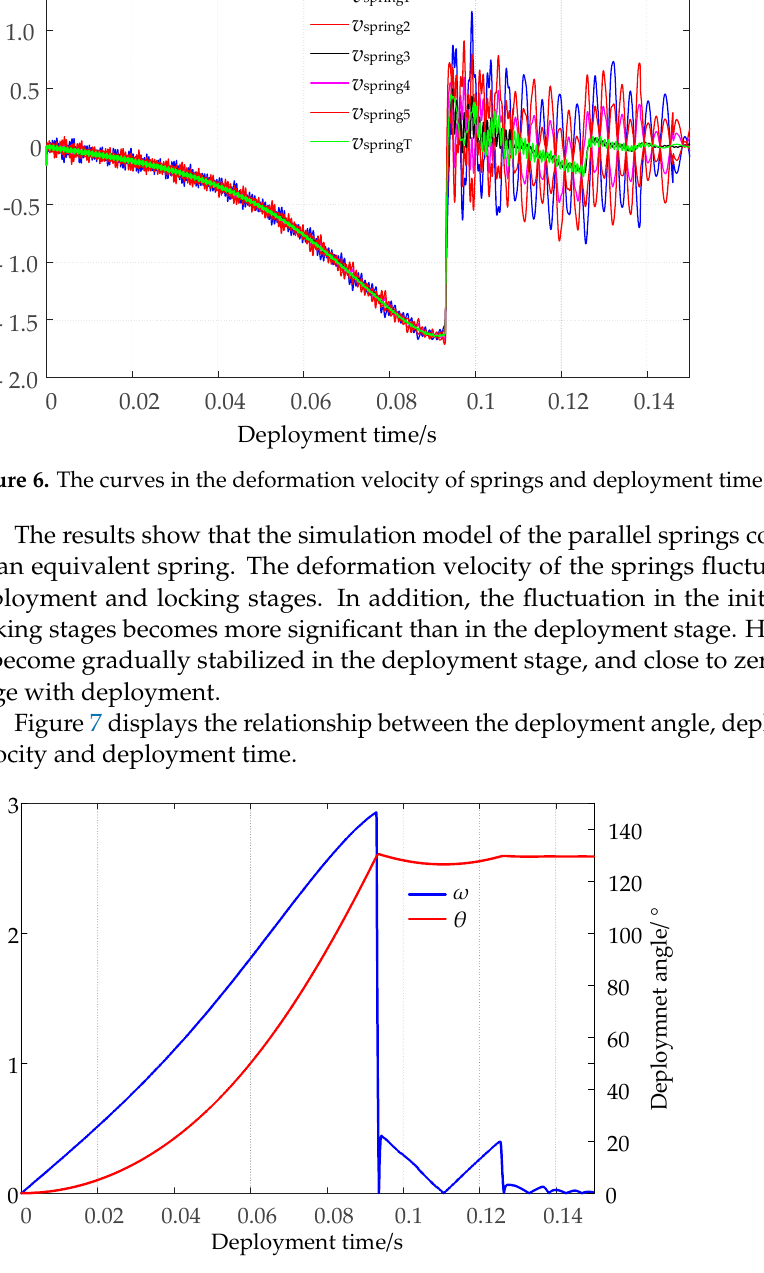
Figure 7. The relationship between deployment angle, deployment angular velocity and time. The results show that when the angle reaches the prescribed position, the time is equal to 0.0921 s, and the outer wing collides with the inner wing. At the same time, the deployment angular velocity reaches the maximum value, namely, 2924°/s; In addition, the outer wing moves backward slightly when the deployment angle reaches 130.2° since the inner and outer wing penetrate into each other. The relationships between the displacement of locking springs and deployment time are shown in Figure 8.